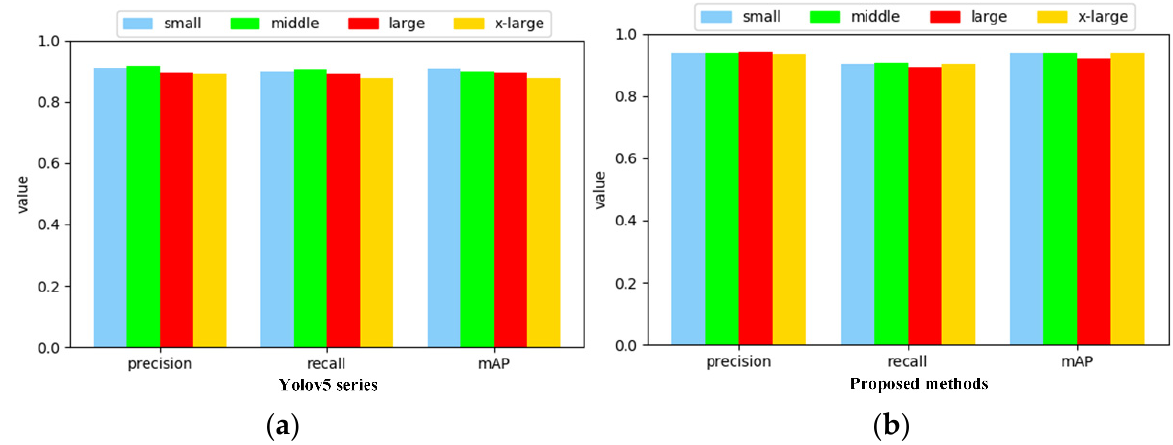
Figure 16. Comparison of DR image detection performance of yolov5 ( a ) with the proposed method ( b ) in deeper and wider networks.